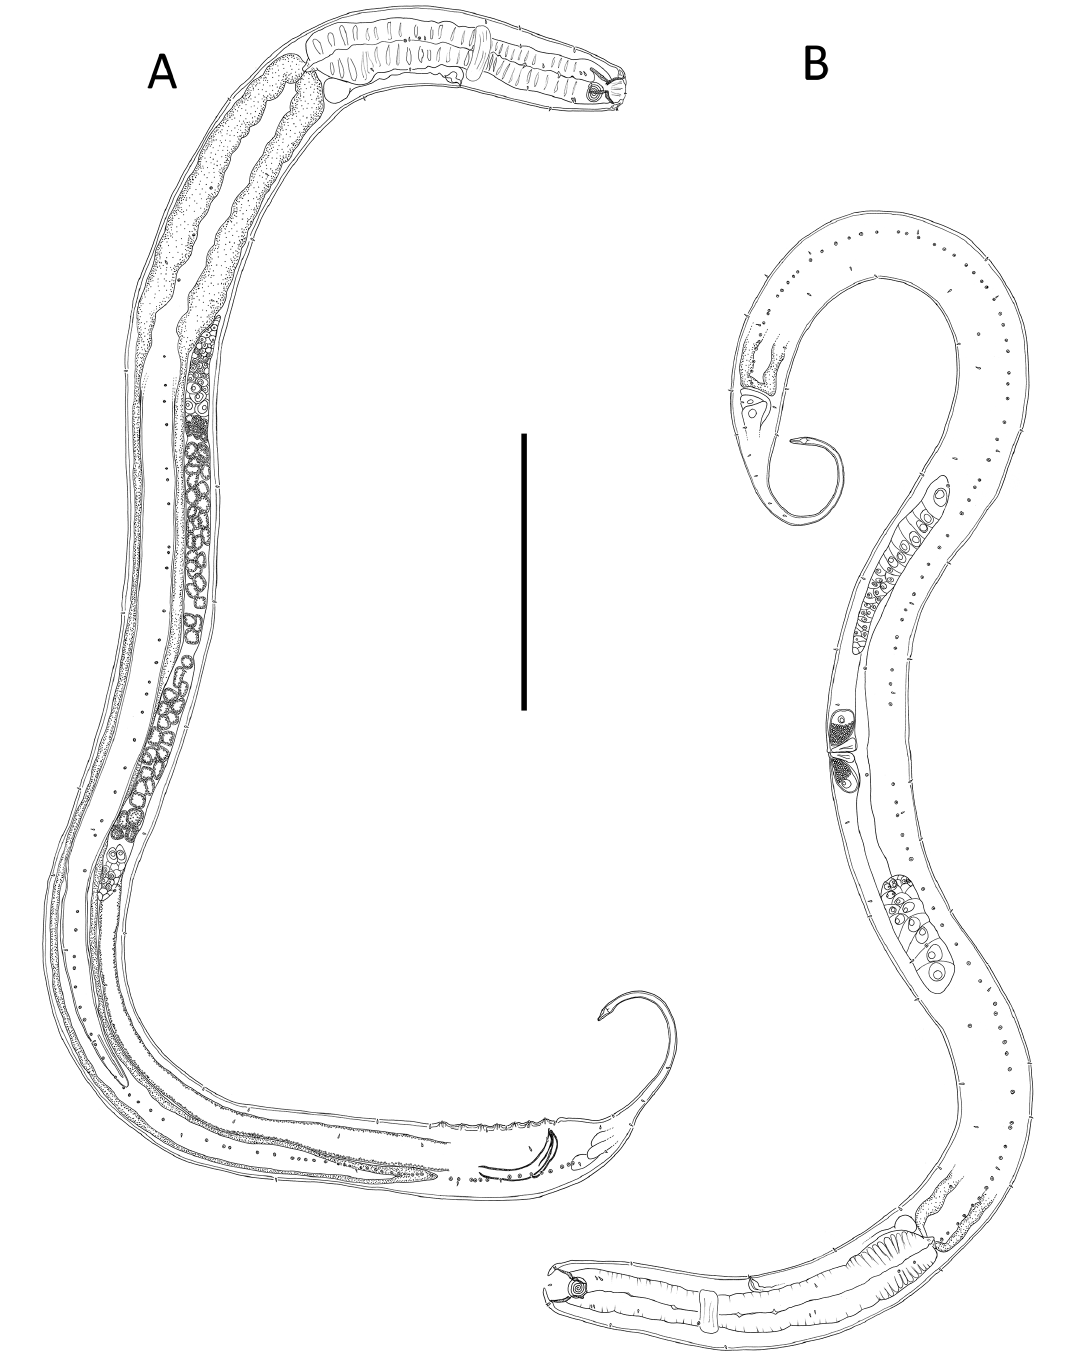
Fig. 2. Halichoanolaimus ovalis Ditlevsen, 1921 A . Entire ♂. B . Entire ♀. Scale bar: 200